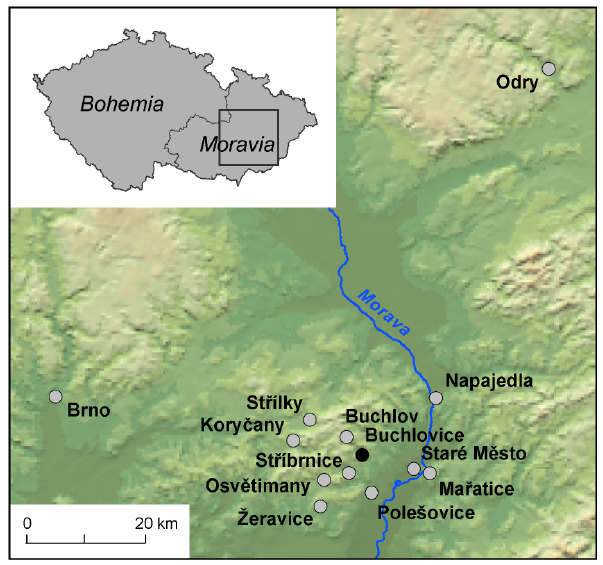
Figure 1. Locations of places within the Czech Republic referred to in this